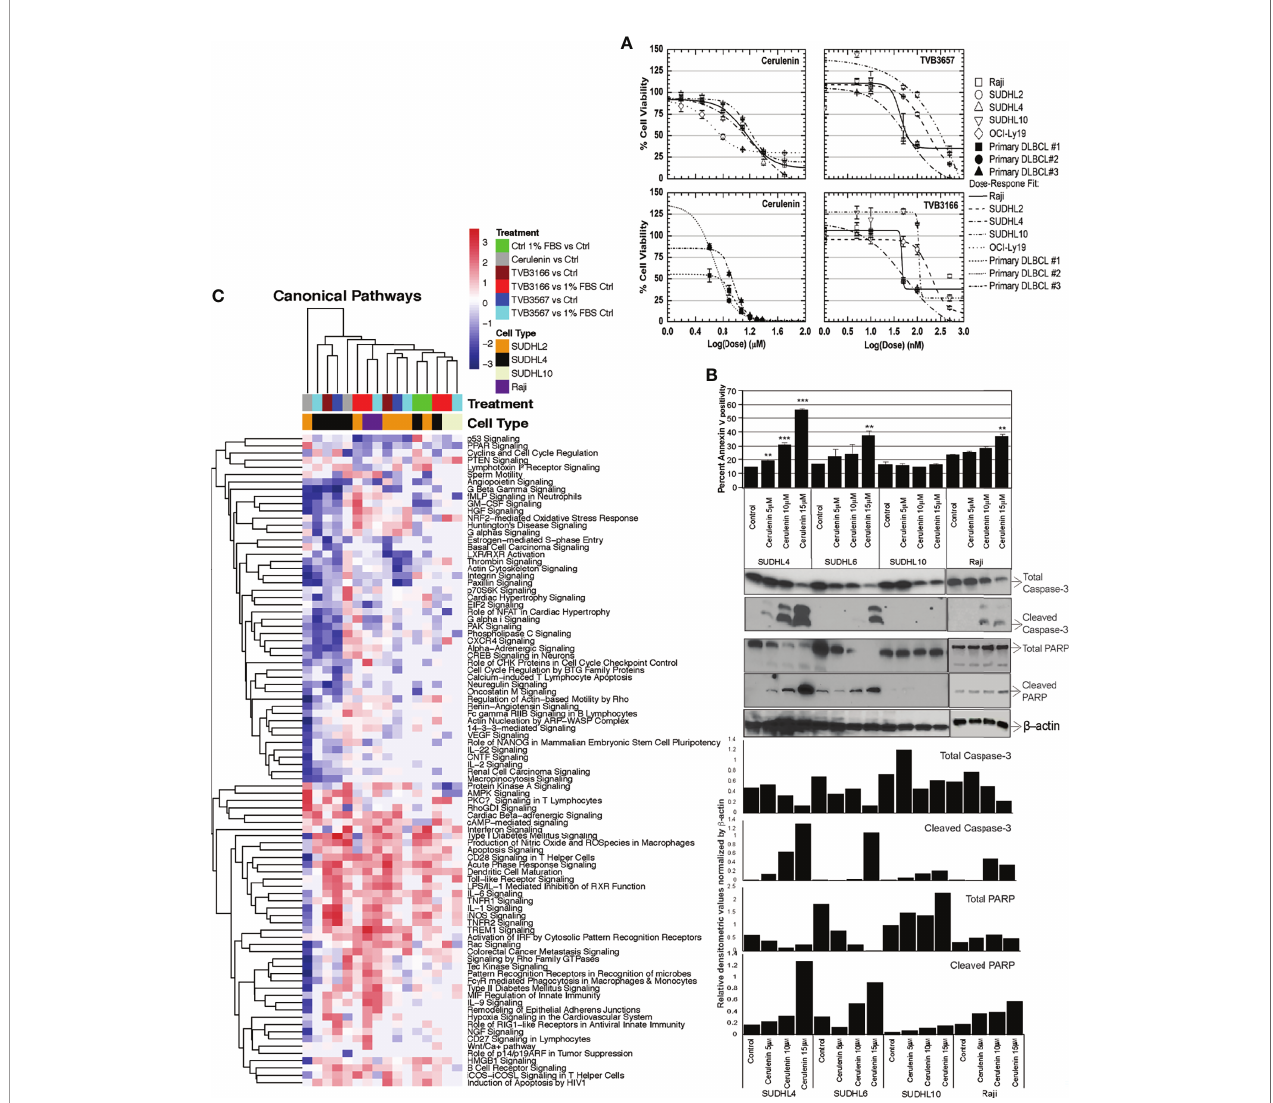
FIGURE 1 | Cell viability, apoptosis, and transcriptomic analysis with FASN inhibitors in bNHL. (A) Dose – response curves from cerulenin-, TVB3166-, and TVB3567- treated bNHL cell lines and patient-derived primary bNHL (DLBCL) cells, with concentration in (x-axis) and dependent decrease in percent cell viability plotted in (y- axis), determined at 72 h by MTT assay with cerulenin or at 7 days by CellTiter-Glo assay with TVB3166 and TVB3567. (B) Bar chart representing annexin-v staining positivity (y-axis) with cerulenin concentration by individual bNHL cells on (x-axis), determined by fl ow cytometry, along with corresponding western blot analysis for apoptosis markers, showing the activation of caspases and PARP cleavage, below. The error bars represent the standard deviations of mean, and the signi fi cant difference between control and treatment is indicated by an asterisk (** p < 0.05 and *** p < 0.005) statistically determined by Student ’ s t -test. The bar graph below the western blots represents the ratio of caspase-3 or PARP products normalized by total b -actin. (C) Hierarchical clustering showing the canonical pathway changes as a heat map of Z scores representing activation or inhibition occurring with cerulenin or TVB3166 and TVB3567 treatment in lymphoma